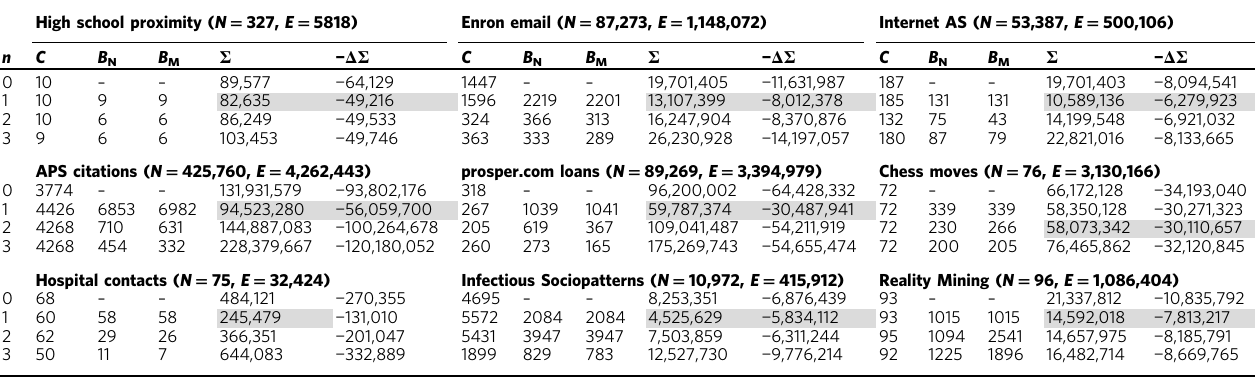
Table 2 Summary of inference results for empirical temporal